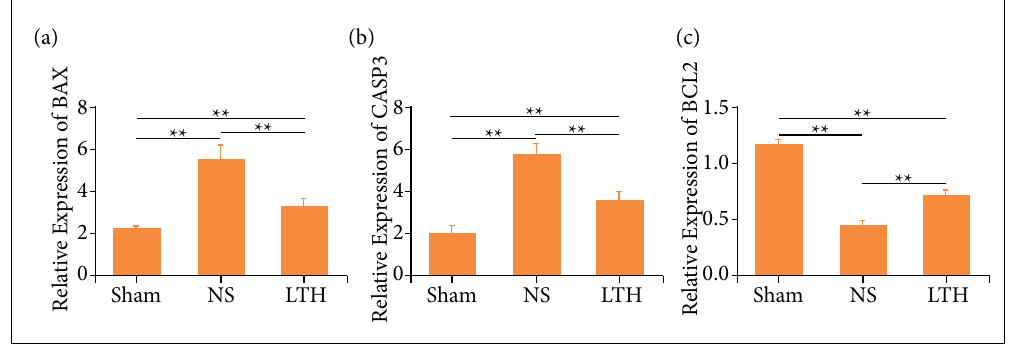
Figure 5 - Lutongkeli treatment reduced the level of apoptotic cytokine and increased the level of anti-apoptotic cytokine. ( a, b, c ) Real-time polymerase chain reaction was employed to check the mRNA level of Bax, Caspase3 and Bcl-2 at one-day post operation Data were presented as the mean ± standard deviation, N =